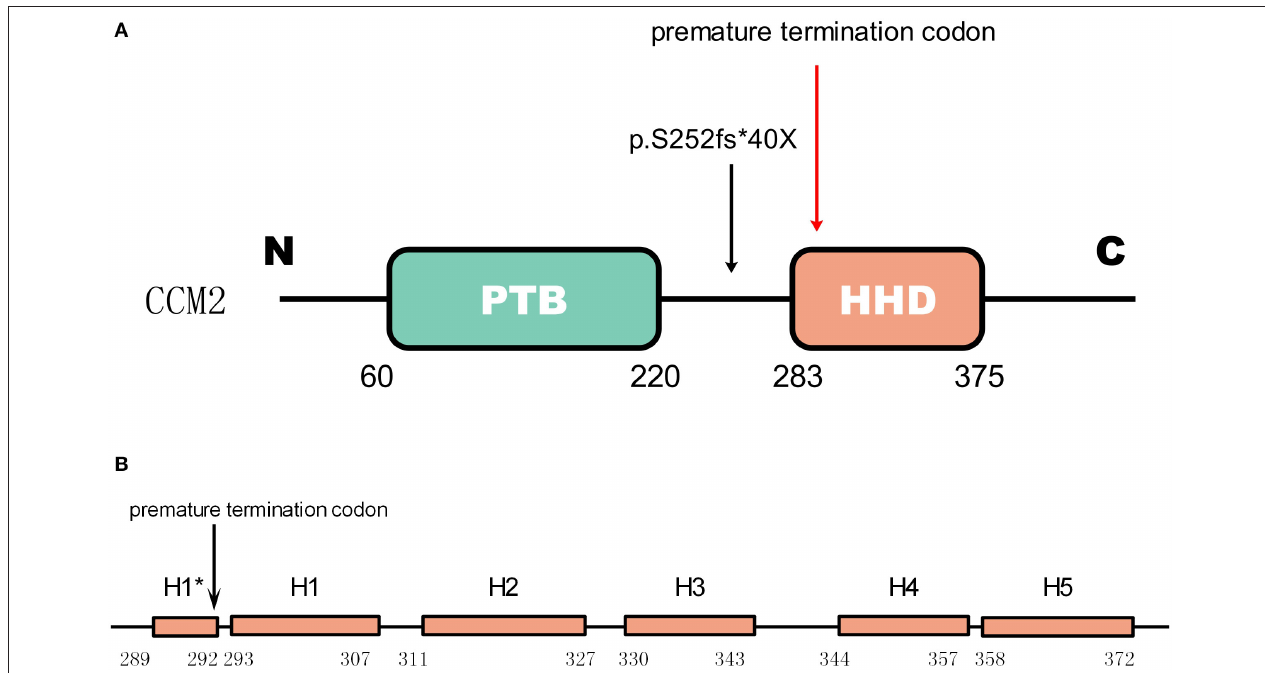
FIGURE 4 | The mutation in CCM2 domains (A) shows the domains of CCM2. The green box represents the PTB domain [residues 60–220(15)]. The red box represents the HHD [residues 283–375(16)]. The mutation in the patient is indicated by a black arrow, and the premature termination codon (40 amino acids downstream) due to the frameshift is indicated by a red arrow. (B) Helices H1 to H5 with a 4-residue helix H1* (16). The premature termination site is indicated by the black arrow. This mutation causes a loss of almost all of the